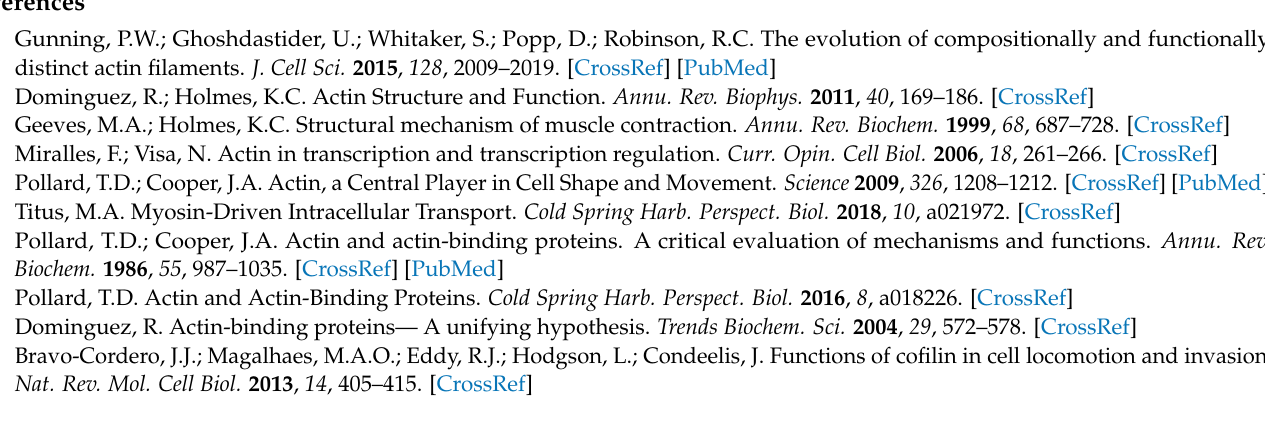
and Supplementary Item Table S2: Summary of cryo-EM structures deposited in the PDB and Supplementary Item Table S3: Strength of the Actin-Myosin Interface